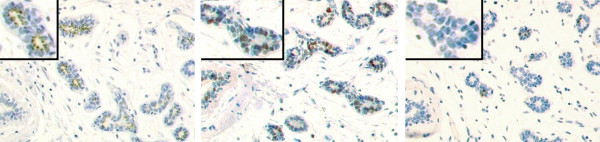
Immuno-reactivity of normal mammary epithelium in three serial sections incubated with: a, anti DMBTh12 Ab; b, anti MCM5 Ab and c, anti Ki 67 antibody where only few cells are labelled. Inset: higher magnification of the same ductal structure.